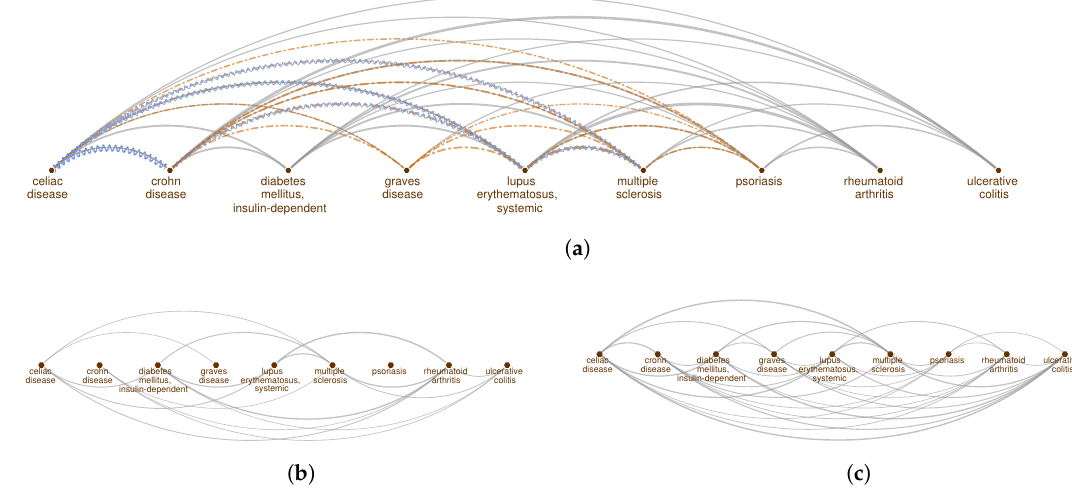
Figure 1. Genetic, phenotypic and functional overlap across autoimmune disorders. Disease relationships (links) based on ( a ) shared genes (gray solid lines), shared symptoms (orange dashed lines) and comorbidity (blue sinusoidal lines); ( b ) shared pathways (gray solid lines) using common disease and pathway genes, ( c ) shared pathways (gray solid lines) using the proximity of the pathway genes to the diseases genes in the